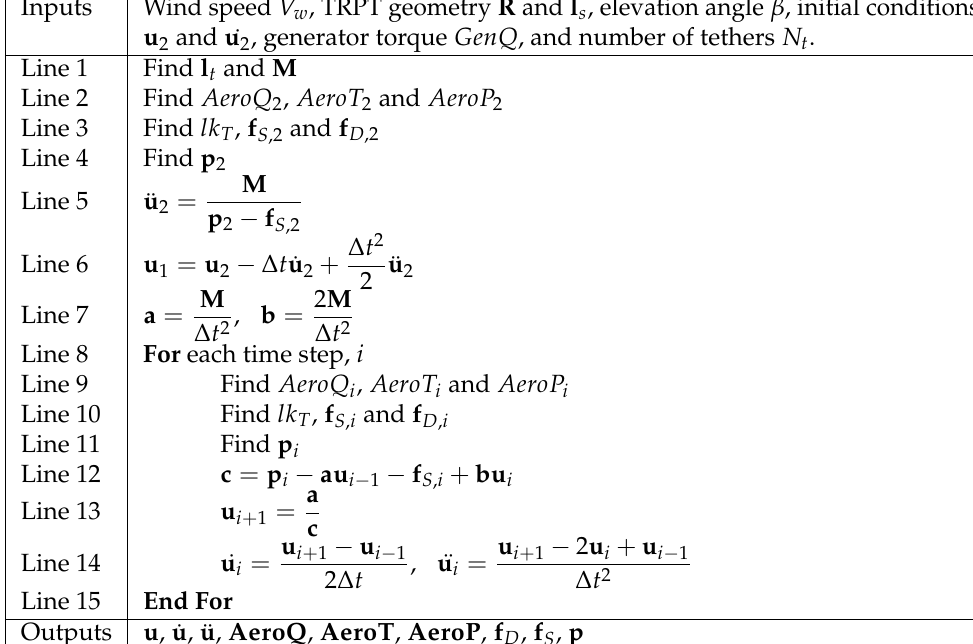
Table A2. Pseudo code for the multi-spring TRPT representation. R is the vector for the discs radii, l s is the vector containing the TRPT section lengths, l t the vector for tether lengths in each TRPT section, M the mass and inertia matrix, AeroQ the rotor torque, AeroT the rotor thrust, AeroP the rotor power, lk T the lift kite line tension, f S the spring forces, f D the aerodynamic forces on the tethers, p the force applied to each point mass, ∆ t the time step length and u , ˙ u , ¨ u the vectors containing the masses positions, velocities and accelerations respectively. a , b , c are variables used within the algorithm. Inputs Wind speed V w , TRPT geometry R and l s , elevation angle β , initial conditions u 2 and ˙ u 2 , generator torque GenQ , and number of tethers N t